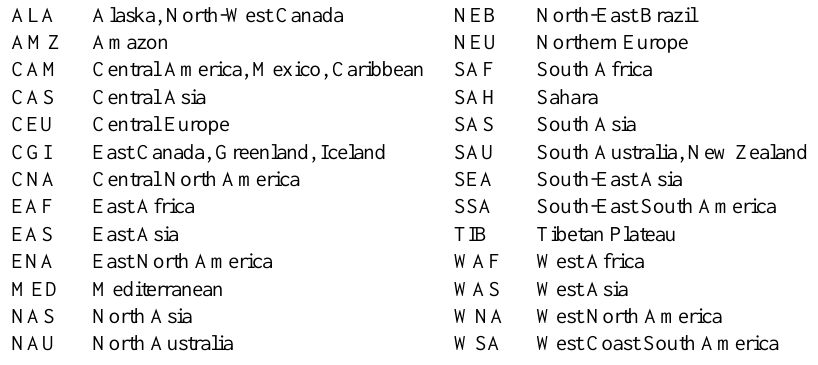
Table 1. Overview of the world regions used as well as the respective acronyms based on IPCC (2012). Please note that the Central Ameri- can (CAM) region has been extended eastwards to also include the